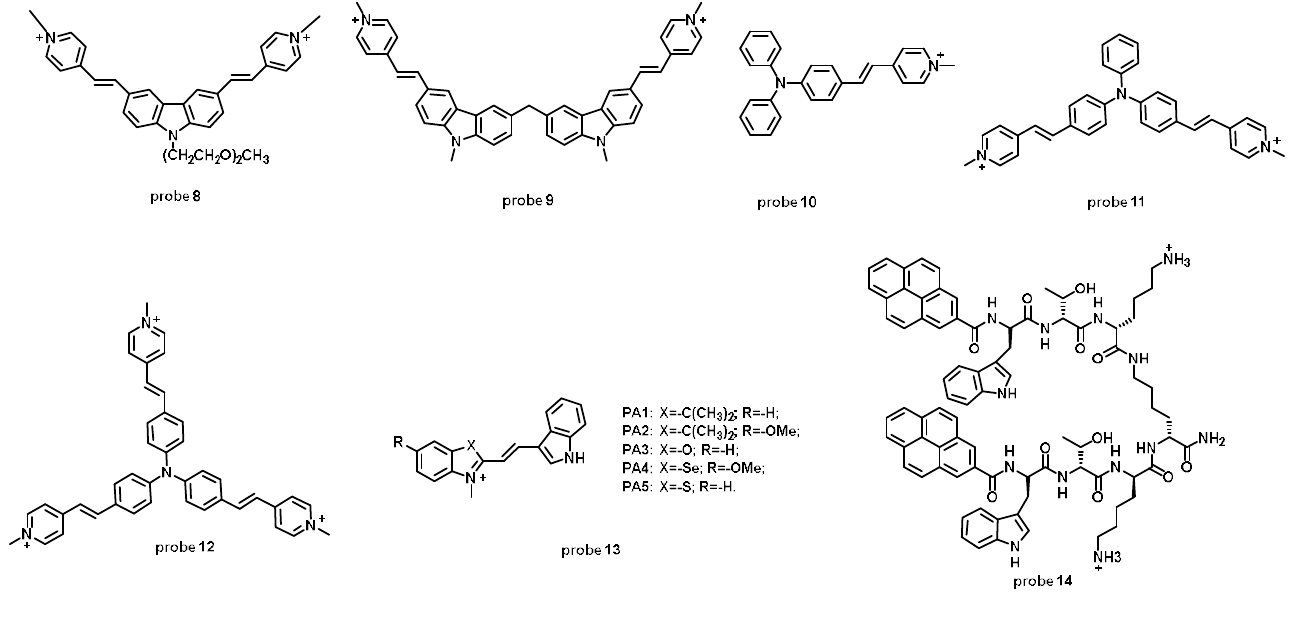
Figure 12. The chemical structures of probe 8–14.